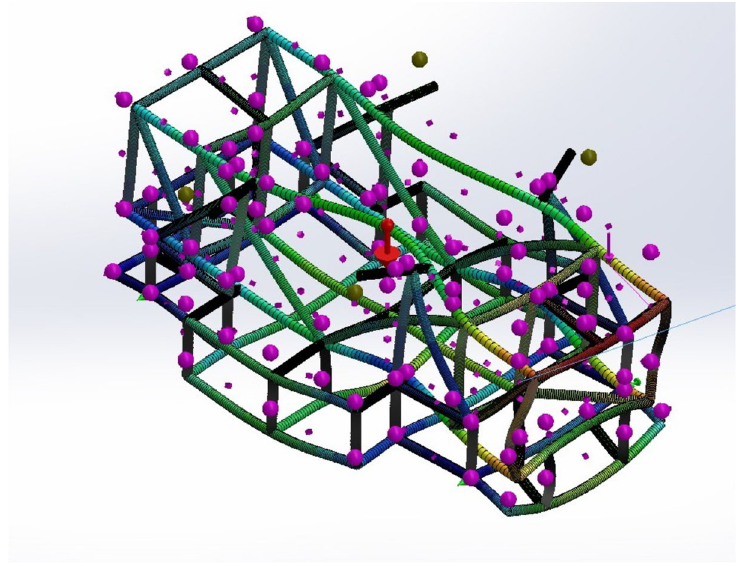
Figure 17. Schematical illustration of the case study and its loads.